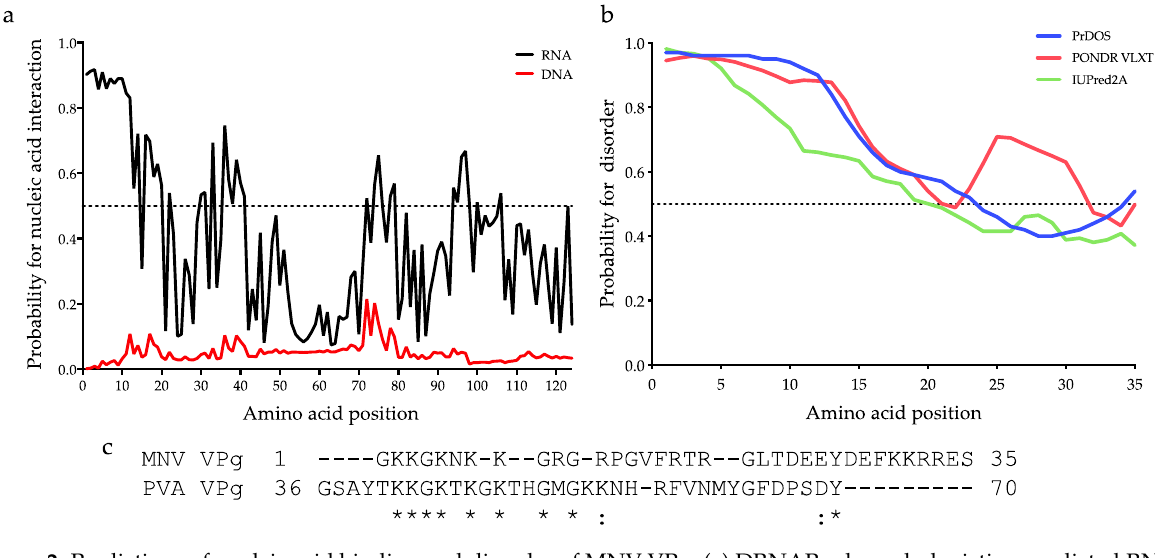
Figure 2. Predictions of nucleic acid binding and disorder of MNV VPg. ( a ) DRNAPred graph depicting predicted RNA (black) and DNA (red) binding probabilities of MNV VPg. ( b ) Predictions for propensity of disorder of the first 35 N-terminal amino acids of MNV VPg using PrDOS (blue), PONDR VLXT (red), and IUPred2A (red) servers. Regions with predictions above 0.5 were considered disordered [33] and are indicated by the dotted line. ( c ) Alignment of the first 35 N-terminal amino acids of MNV VPg and the RNA binding region of PVA VPg. An asterisk (*) indicates fully conserved amino acids and a colon (:) indicates amino acids of a similar nature.